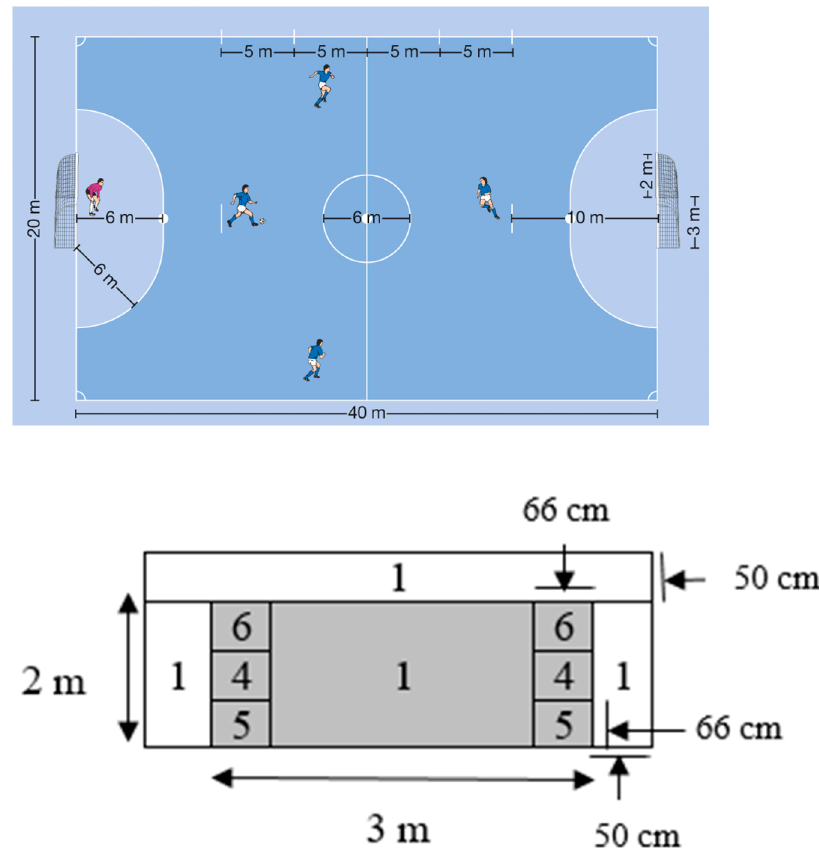
Figure 2. The goal-shooting test scores (Schöllhorn et al. 2012).